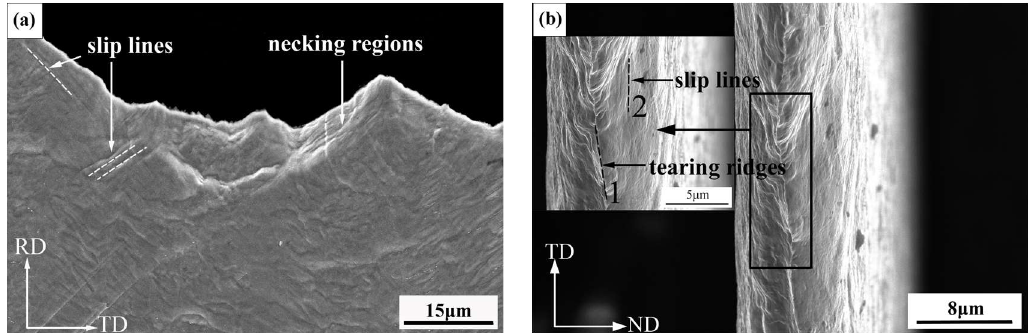
Figure 12. Morphological characteristics of the copper foil annealed for 10 min. ( a ) Surface morphol- ogy; ( b ) Fracture morphology.